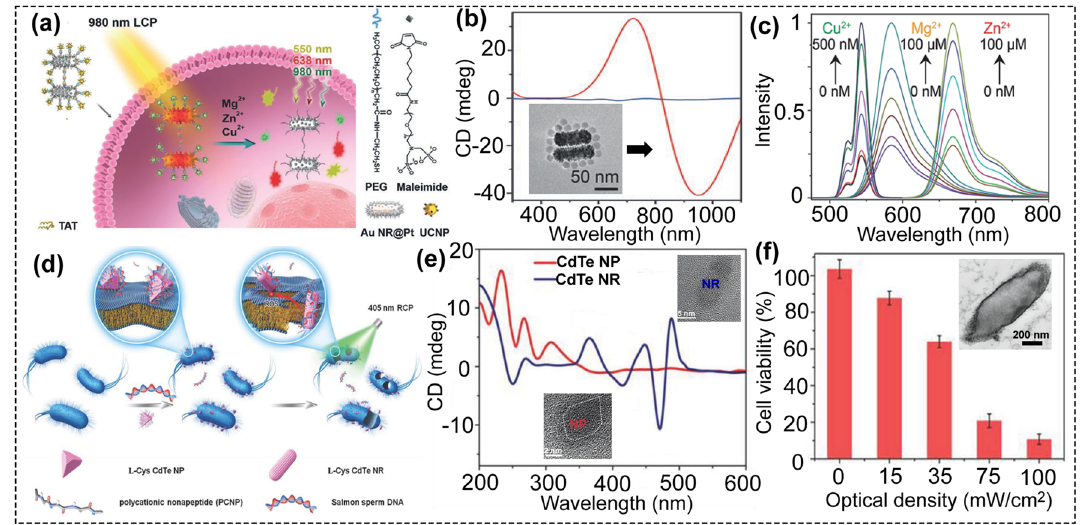
Fig. 6 a Schematic illustration of the Au NR@Pt dimer-UCNP satellites for intracellular triple-ion detection. b CD spectra of the Au NR@Pt dimer-UCNP satellites, and the inset is the typical TEM image of the Au NR@Pt dimer-UCNP satellites. c Normalized fluorescence intensity of satellite assemblies with various concentrations of the Cu2+, Zn2+, and Mg.2+ ions (reproduced with permission from Ref. [86]. Copyright 2019, WILEY–VCH GmbH). d Schematic illustration of the chiral CdTe NPs for combating gram-negative bacteria under CPL illumination. e CD spectra of the CdTe NPs and the CdTe NRs, and the inset is the typical TEM image of CdTe NP and NR. f Cell viability of E. coli incubated with chiral CdTe NPs and then treated with different illumination intensities (405 nm, 30 min). The inset is the TEM image of the E. coli after treating with chiral CdTe NPs and CPL (reproduced with permission from Ref. [89]. Copyright 2018, WILEY–VCH